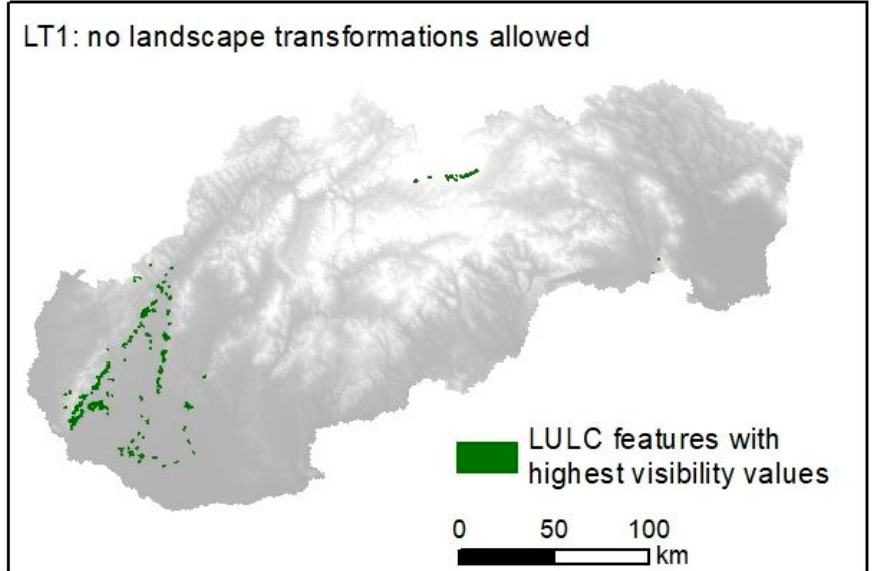
Figure 7. Maps of the different proposed norms: LT1.